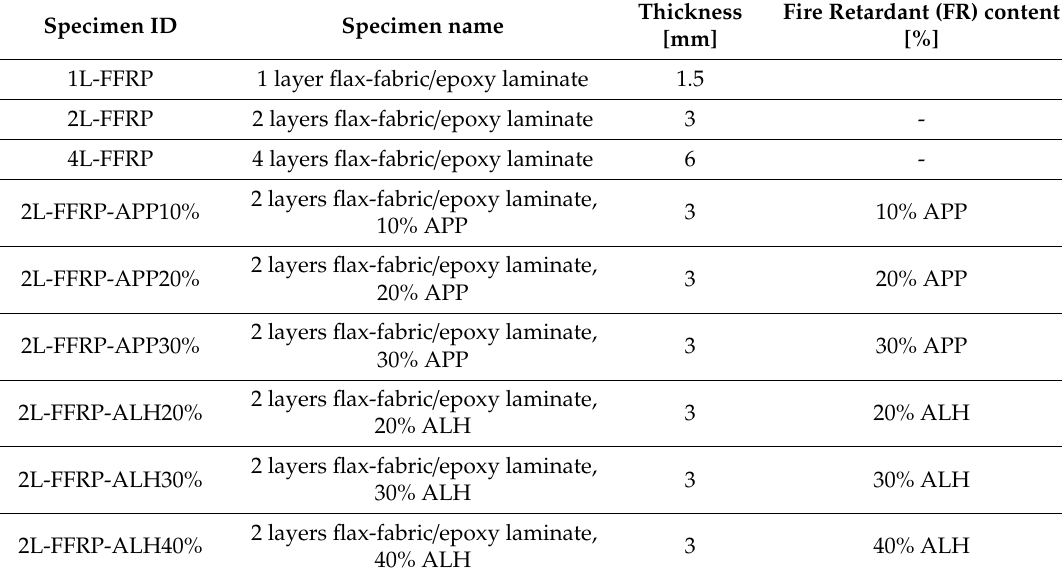
Table 1. Tested composites with corresponding abbreviations, thicknesses, and matrix